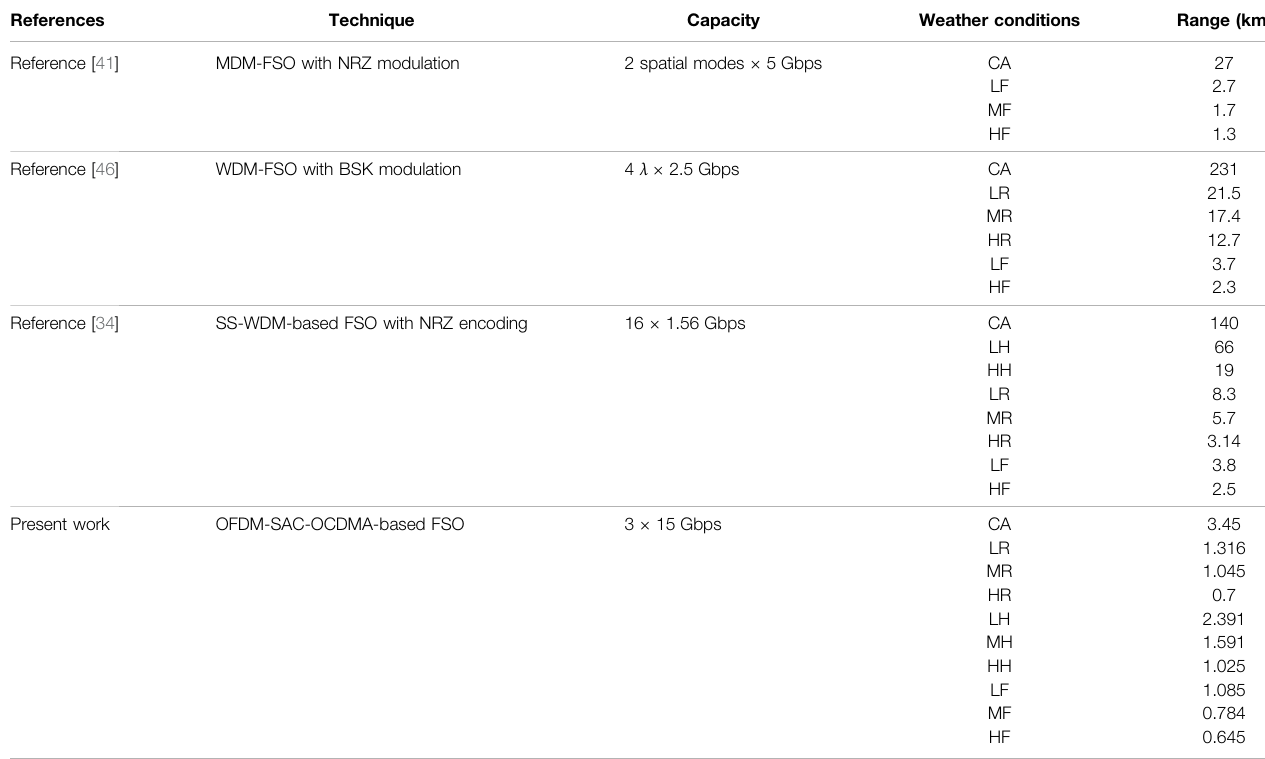
TABLE 11 | Comparison between past published works and our